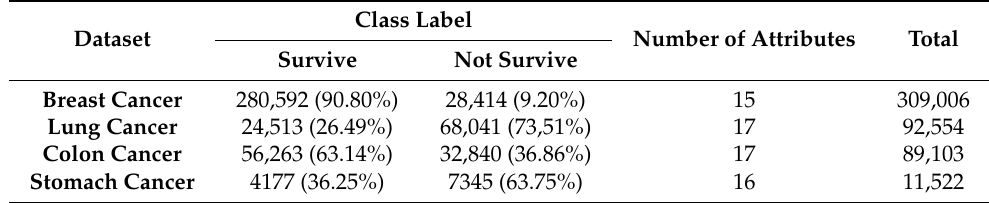
Table 1. Characteristics of the extracted datasets.